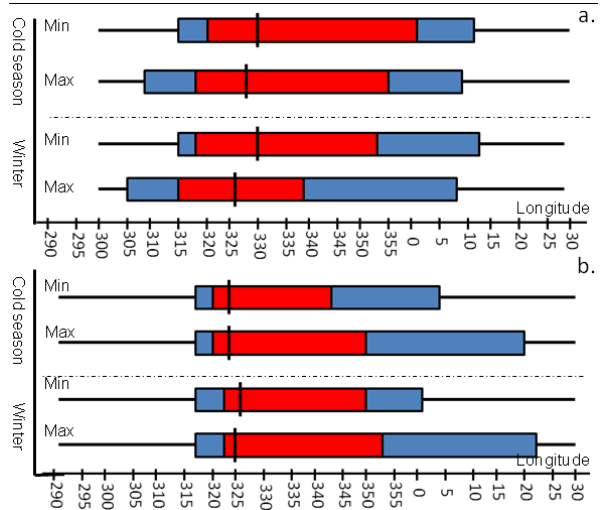
Figure 7. Cumulative longitudinal position frequency of the min- imum SLP (a) and maximum SLP (b) for different solar activity conditions (horizontal line, mean position; red box – frequency be- tween first and third quartile; blue box – frequency between first and last decile; whiskers –